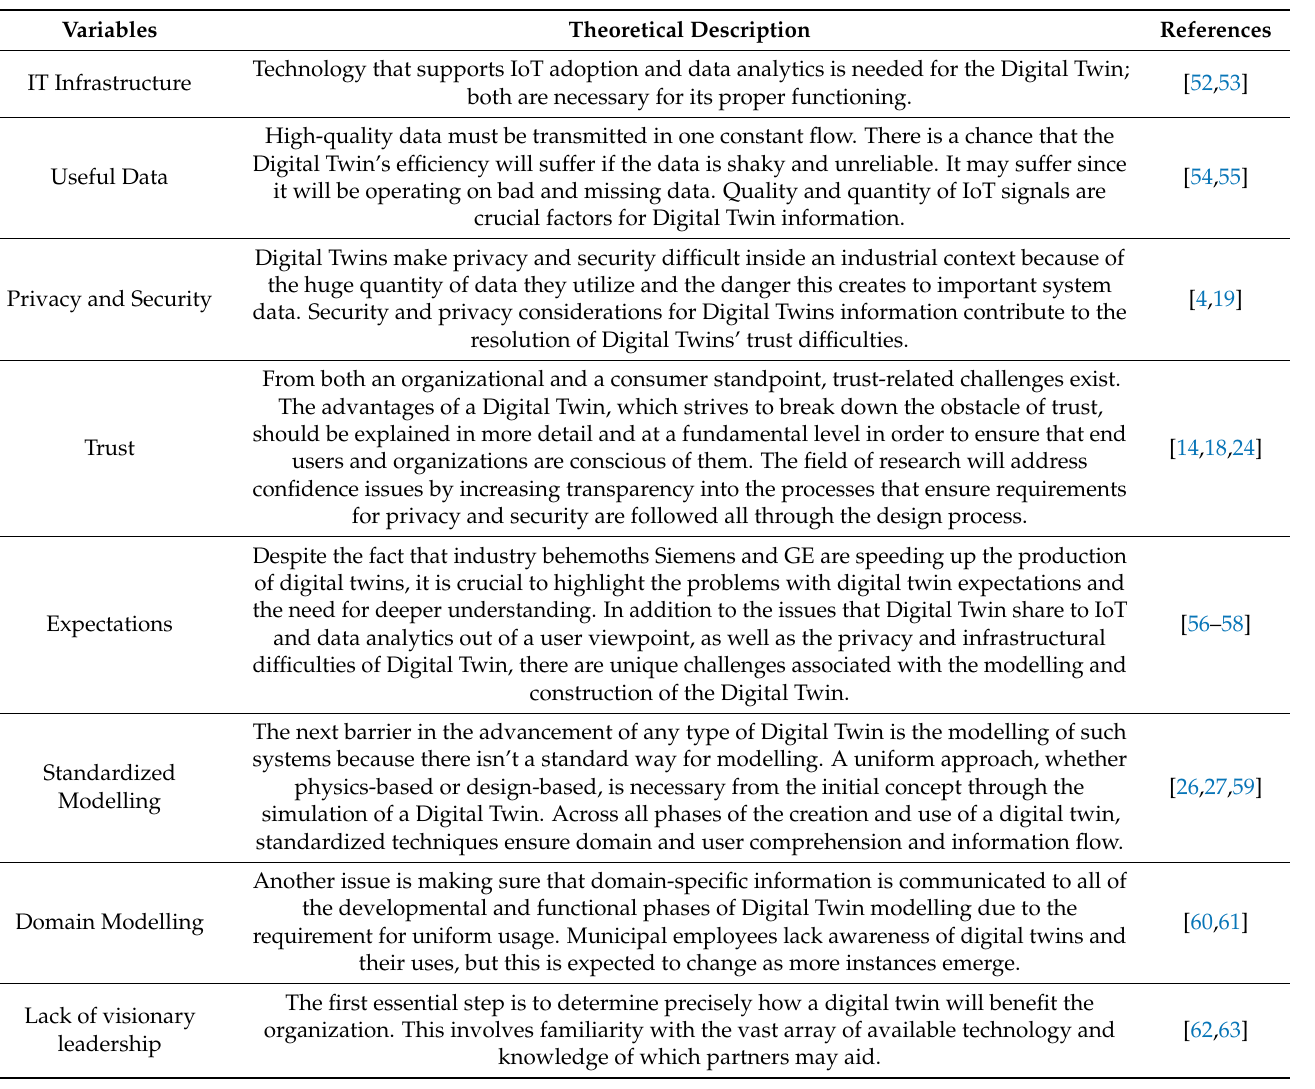
Table 1. Research variables and their